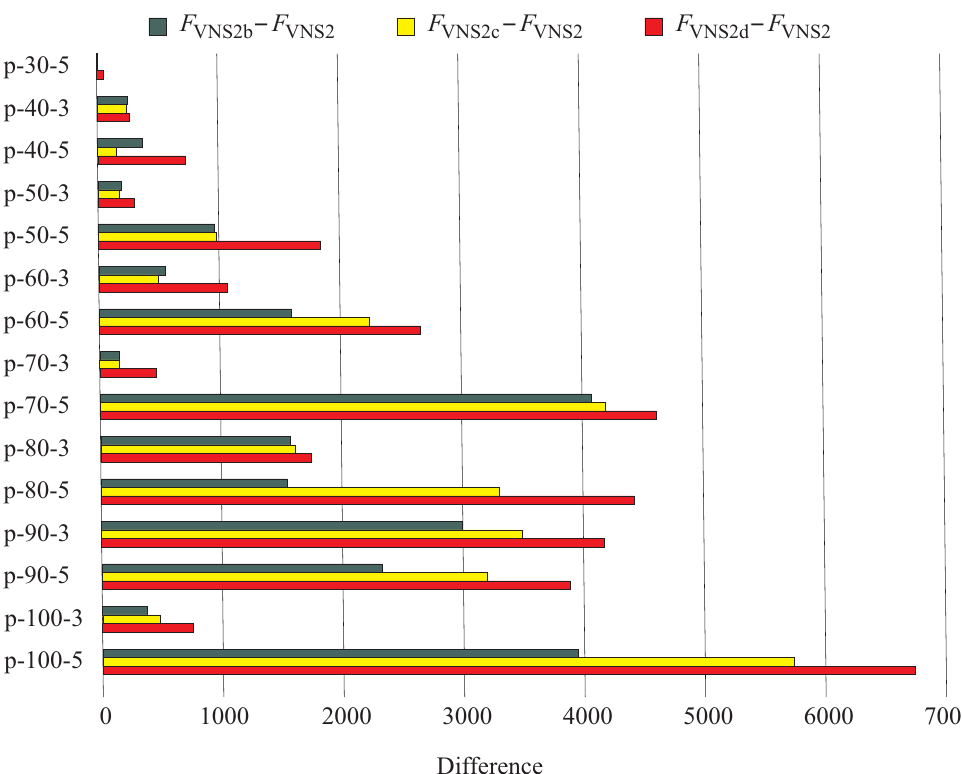
Figure 13. Difference in solution values between the VNS2 algorithm and VNS2 variations VNS2b, VNS2c, and VNS2d: the case of the ¯ F